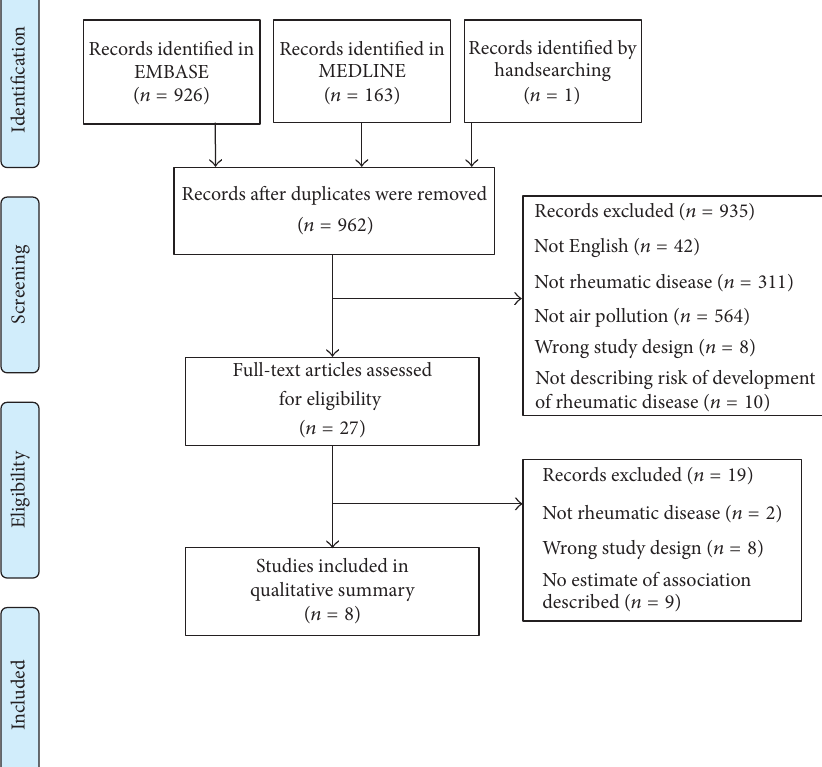
Figure 1: Study selection.